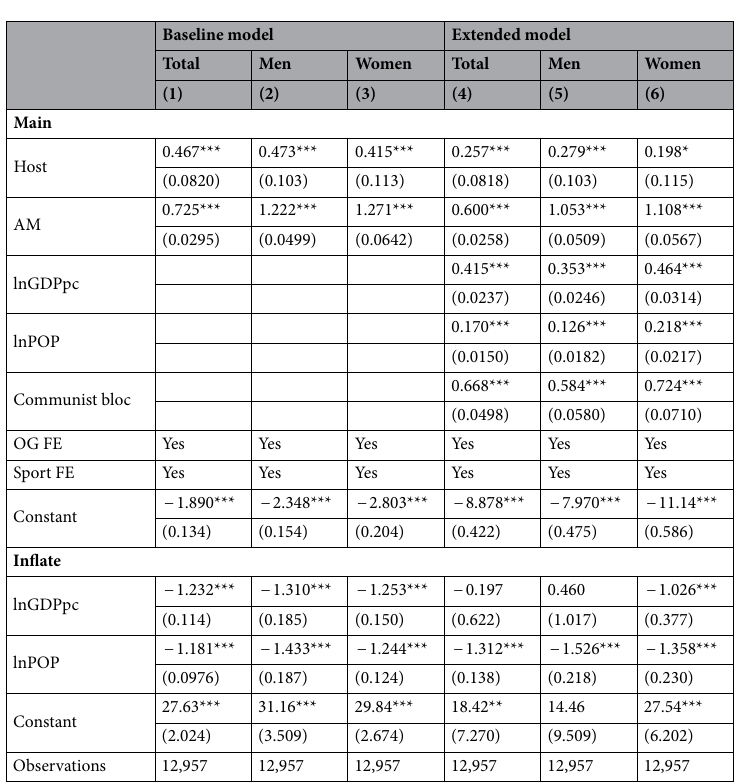
Table 1. Effects of hosting the Olympic Games with an aggregate dummy variable. Robust standard errors in parentheses. * p < 0.1, ** p < 0.05, *** p <